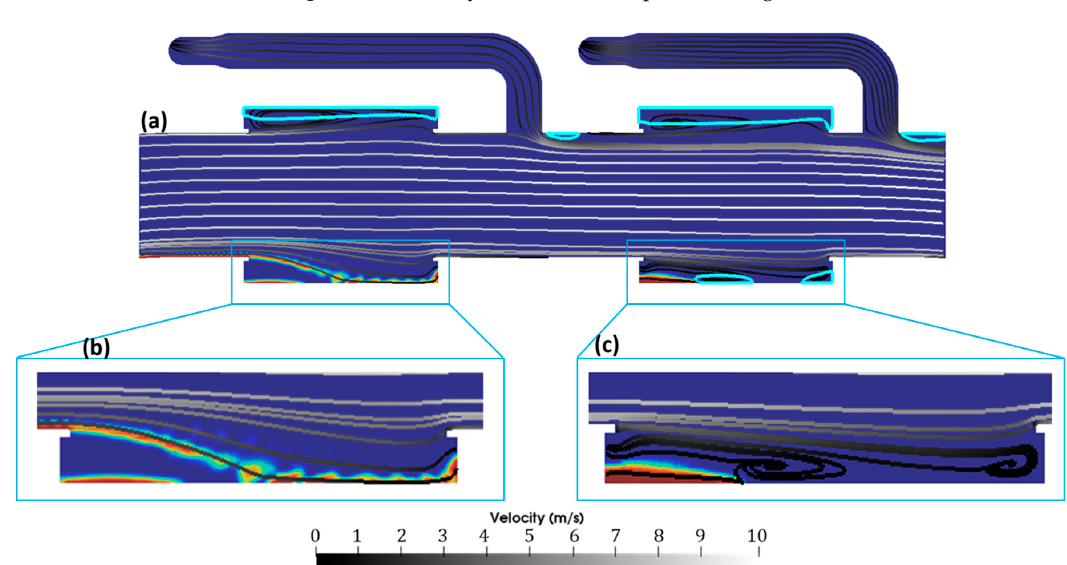
Figure 10. Instantaneous velocity streamlines for case 2 (i.e. U G = 7.7 m/s). In comparison to the first design, the second separator unit is much more e ffi cient at removing liquid, preventing the liquid build-up on its right wall. ( a ) View of both separators and main pipeline in an xy slice at the center (z-direction) of the geometry. ( b ) View of the rightmost, bottom part of the first separator unit. ( c ) View of the rightmost, bottom part of the second separator unit.